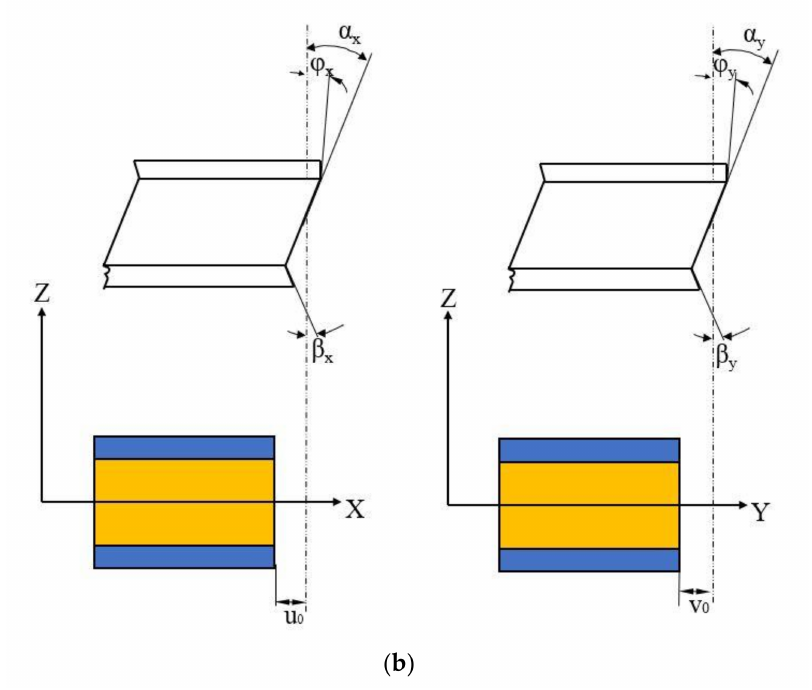
Figure 1. Graphical illustration of the ( a ) Laminated Composite Sandwich (LCS) plate and ( b ) kine- matics of deformation of the LCS